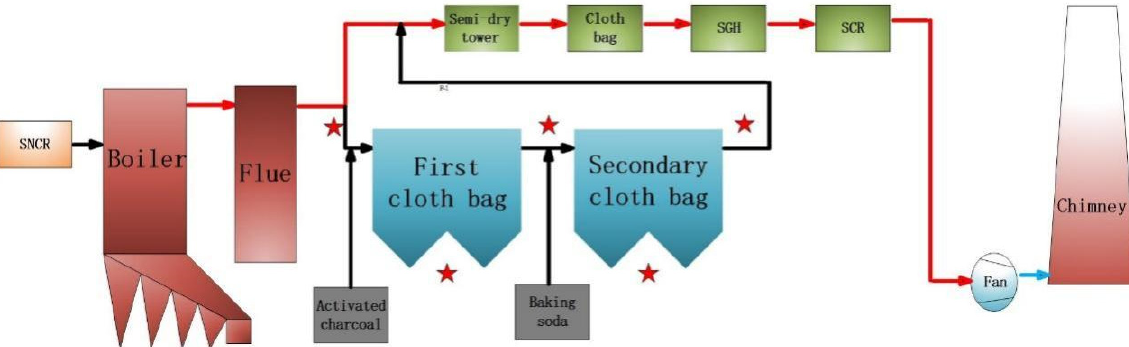
Figure 1. The structure of the test bench of the light and large double bag system (the red stars means the sampling points).